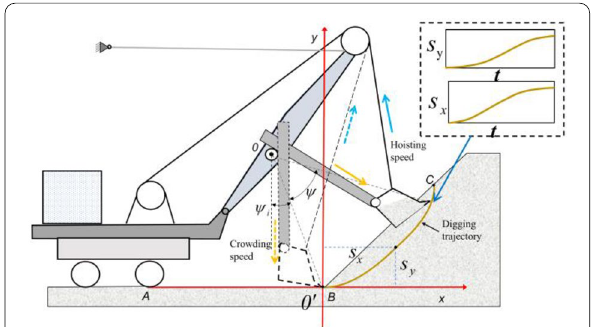
Figure 8 The Cartesian coordinate system built to describe the digging